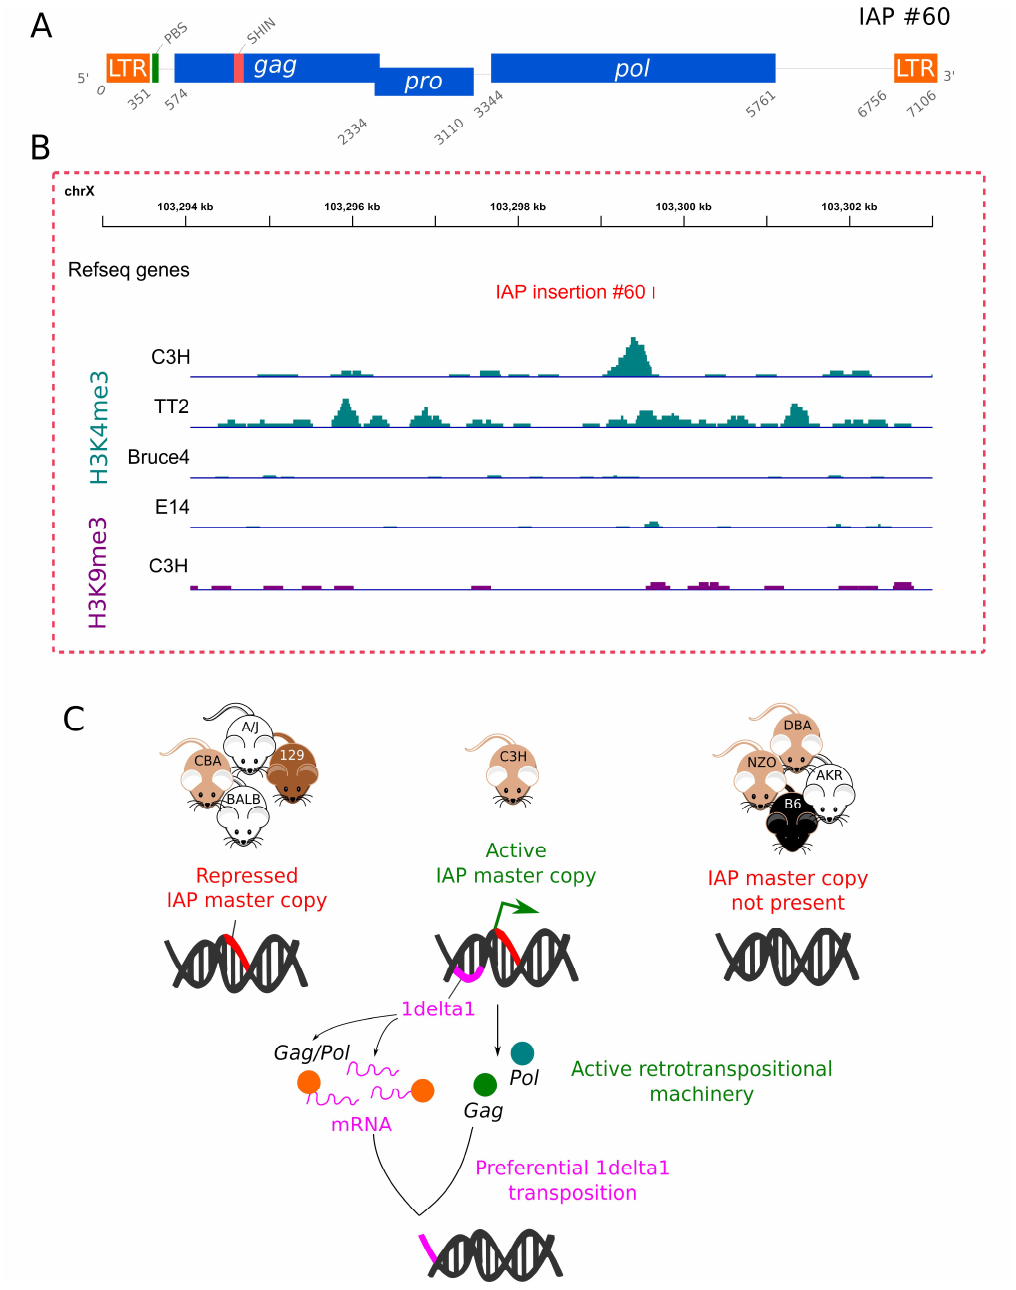
Figure 6. The IAP master copy. ( A ) Diagram of the potential IAP master copy (IAP #60) with intact open reading frames coding gag, pro and pol, an intact PBS region (green) and the presence of the repressive SHIN region (pink). ( B ) IGV genome browser view of the master copy, which is present in the C3H/HeJ genome along with the 129 genome (E14 ES cells), but is absent from the C57BL/6 genome (Bruce4 and TT2 ES cells). H3K4me3 enrichment is only observed in the C3H/HeJ cells. The position of the insertional polymorphic master copy is depicted in red. ( C ) Model of IAP transposition in C3H mice. The C3H master copy is present in several mouse strains, but its permissive state may be specific to C3H mice. The synthesis of functional retrotransposition machinery is, therefore, possible in C3H, and allows 1Δ1 transposition in trans. Colored circles represent proteins produced by full-length IAP (GAG and POL) and a GAG-POL fusion protein produced by 1 ∆ 1 IAP copies, which facilitates their